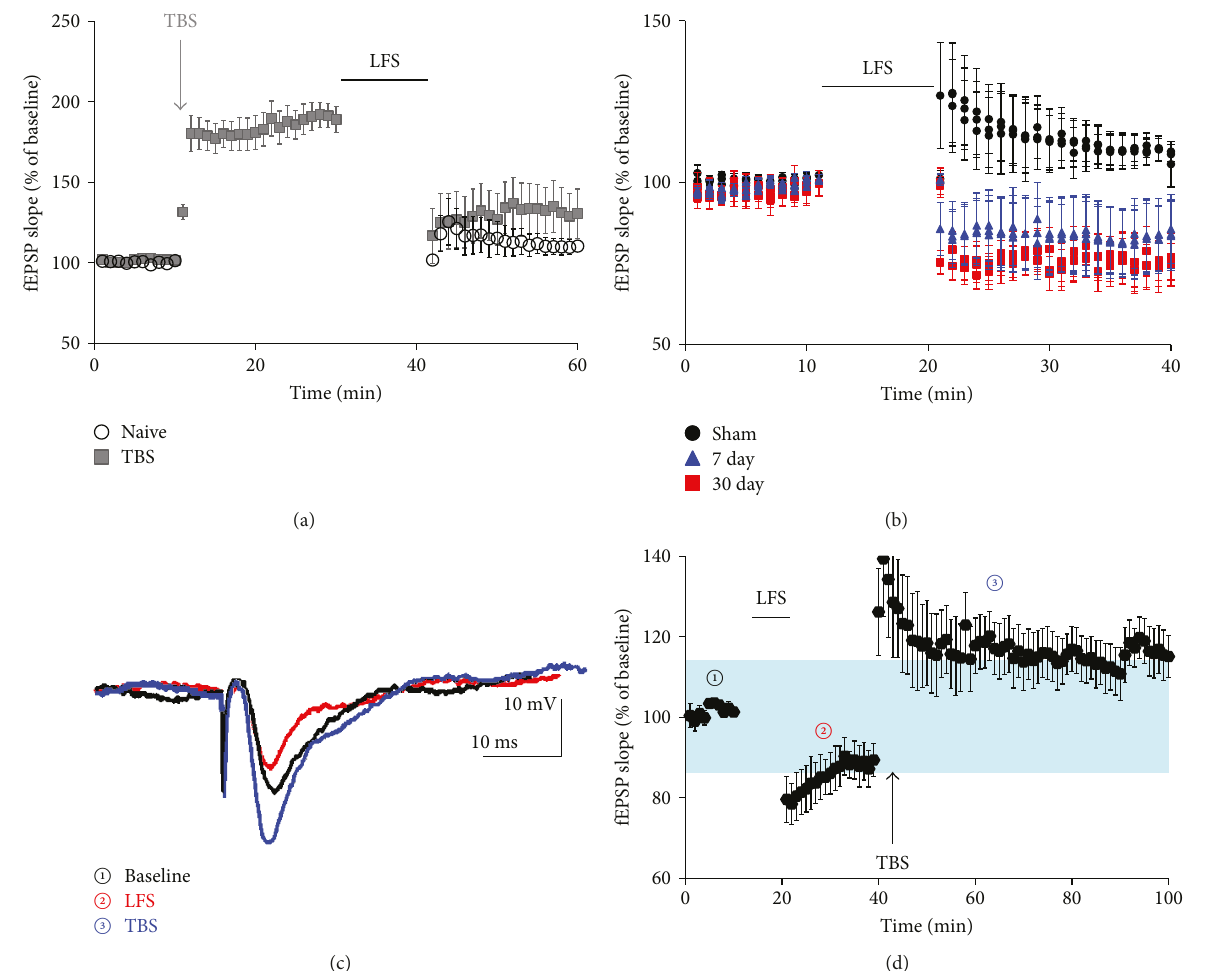
Figure 3: Depotentiation with low-frequency stimulation (LFS) reversed ischemic LTP and partially restored physiological LTP. (a) LFS depotentiates physiological LTP. 20 minutes after theta burst stimulation (TBS), LFS was delivered for 10 minutes (900 pulses at 0.5Hz), resulting in a signi fi cant reduction in fEPSP slope (grey squares). LFS delivered to naive slices that did not receive TBS did not alter fEPSP slope (black circles). (b) LFS was delivered to slices from sham control (black circles) or 7 (blue triangles) or 30 days (red squares) after CA/CPR. LFS reduces fEPSC only in mice that were subjected to CA/CPR, indicating a reversal of iLTP. (c) Representative trace in recordings where we obtained a baseline (black trace) delivered LFS which reduced fEPSP amplitude (red trace) and subsequent TBS, which induced LTP (blue trace). (d) Summary of recordings in which we fi rst delivered LFS then delivered TBS. Numbers on graph correlate with traces in panel (c). Magnitude of pLTP is shaded in